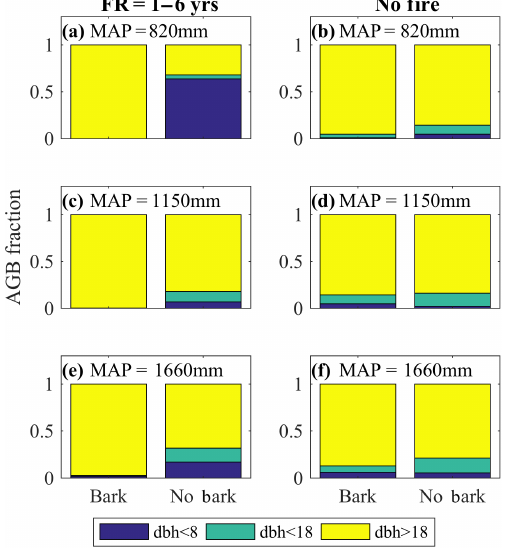
Figure 3. Bark fire survival strategy increases the fraction of above- ground woody biomass in large trees, particularly with frequent fire. Model-simulated fraction of aboveground woody biomass (AGB) present in different tree diameter at breast height (dbh in cm) size classes for 2 < dbh < 8 (blue), 8 < dbh < 18 (cyan), and 18 < dbh (yellow) at low (a–b) , intermediate (c–d) , and high (e–f) MAP for a high-frequency (FR) fire regime (a, c, e) , and a no-fire-disturbance simulation (b, d, f) . Simulations were initialized with tropical tree and C 4 grass plant functional types and included a 100-year model spin-up from seedlings. The subsequent 20-year average AGB frac- tion by tree size class is shown for the model with bark and the model without bark. See Fig. S2 for size class distributions associ- ated with intermediate fire frequency.